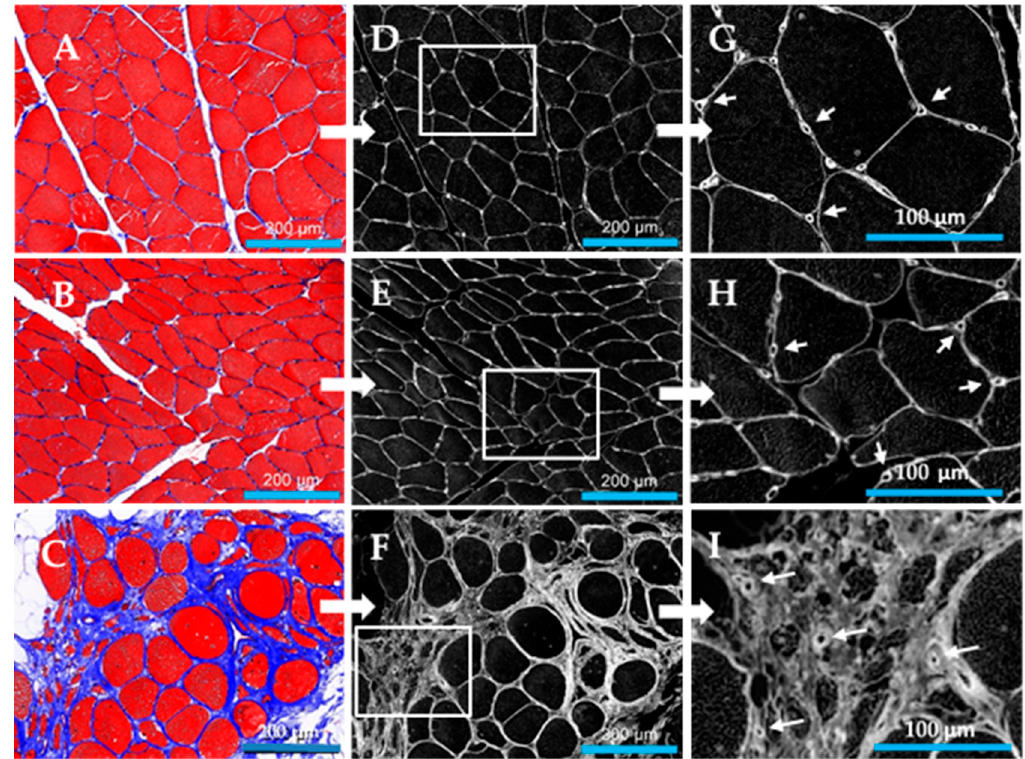
Figure 3. Inter-myofiber collagen deposition in the calf muscle of control subjects and patients with peripheral artery disease (PAD). Slide specimens of calf muscle biopsies fixed and then embedded in paraffin were sectioned at four microns and stained with Masson Trichrome (MT). Inter-myofiber collagen staining ( Blue ) in control calf muscle (Panel ( A )) ( N = 14) is uniform among closely associated myofibers ( RED ) of relatively homogeneous polygonal shape and cross-sectional area. Collagen staining is increased in PAD Stage II (Panel ( B )) ( N = 15) and Stage IV (Panel ( C )) ( N = 15) with the latter presenting remarkable departures in myofiber geometry and collagen deposition compared to both control and Stage II muscle. Stage IV calf muscle exhibited many small degenerating and fragmented myofibers embedded in a large fibrotic matrix, as well as enlarged rounded myofibers, likely necrotic, surrounded by more abundant collagen. Greyscale images of deposited collagen (Panels D – F ) were extracted from Multi-Spectral images of slide specimens stained with MT and captured with the Nuance System (20 × objective). A magnified region (Panels G – I ) of each greyscale image revealed well-defined collagenous rings around the micro-vessels ( Arrows ). Scale bars (Panels A – F ) represent 200 microns.